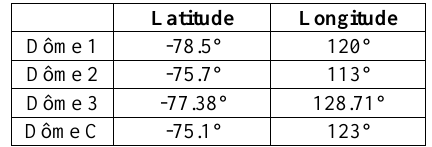
Table 2: Position of the centre of the Antarctic sites.